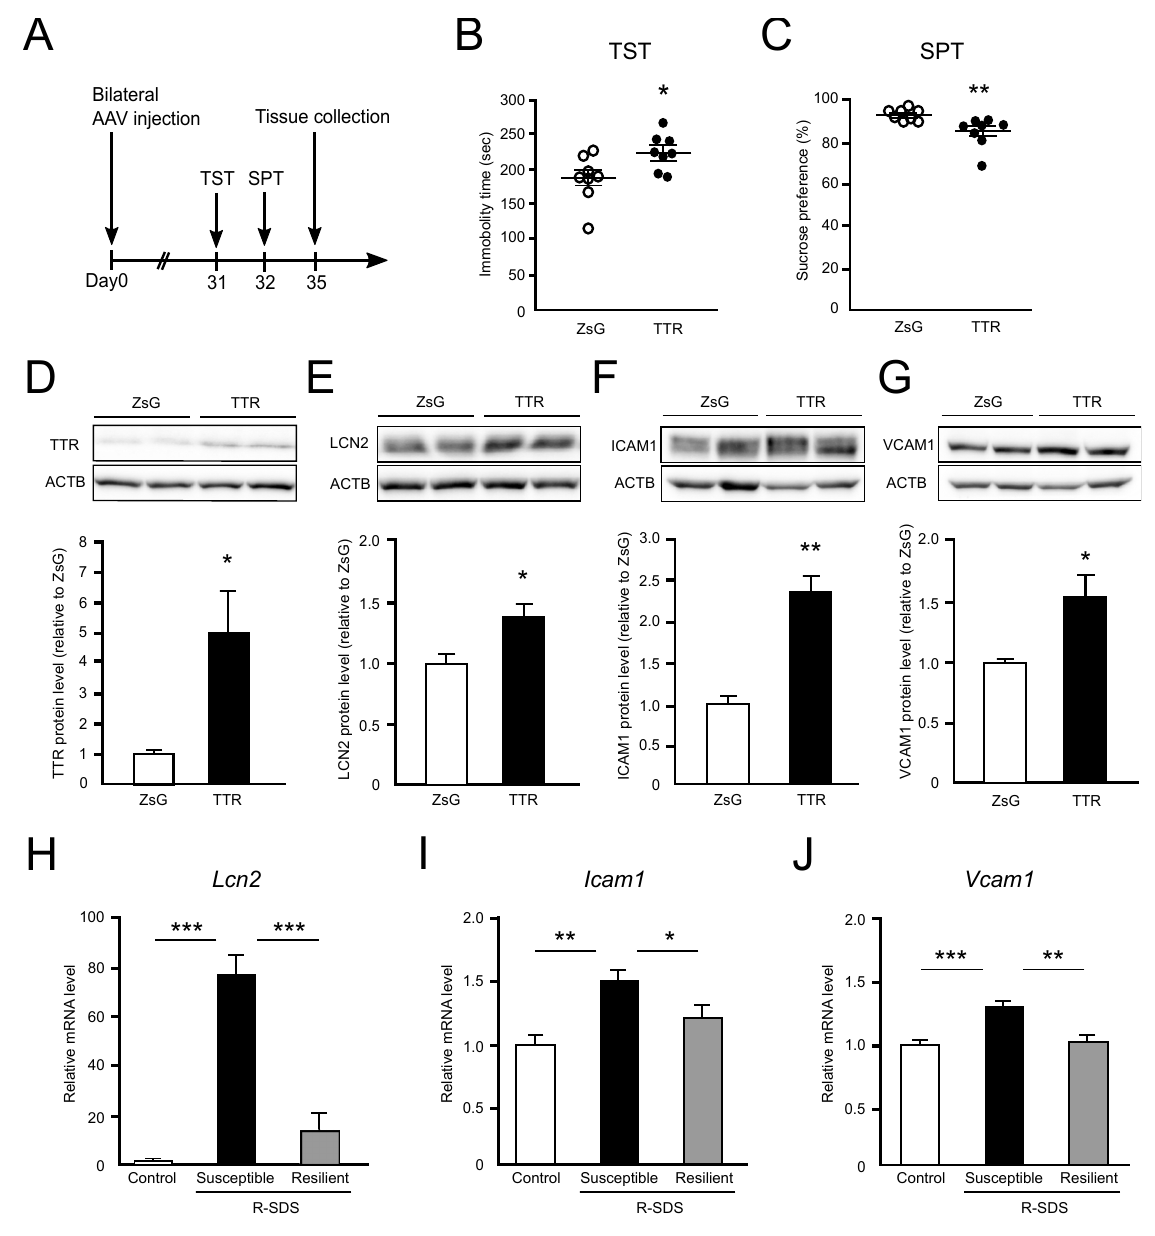
Figure 3. Effects of Ttr overexpression in the hippocampus. ( A ) Schedule of gene transfer and mouse analyses. Male B6 mice were injected bilaterally with AAV-ZsGreen1 (ZsG mice) or AAV-Ttr (TTR mice) into their hippocampus. TST, SPT, and tissue collection were performed 31, 32, and 35 days after AAV injection, respectively. ( B , C ) The immobile time in TST ( B ) and sucrose preference ( C ) of ZsG and TTR mice. Values of each individual were plotted, and mean ± SEM per group was also expressed. ZsG; n = 8, TTR; n = 8. ( D – G ) The protein levels of TTR ( D ), LCN2 ( E ), ICAM1 ( F ), and VCAM1 ( G ) in the hippocampus of the ZsG and TTR mice. Western blotting was performed using whole hippocampus extracts of the ZsG and TTR mice. Data were expressed as mean ± SEM (n = 4). ( H – J ) The mRNA levels of Lcn2 ( H ), Icam1 ( I ), and Vcam1 ( J ) in the hippocampus of the control, susceptible R-SDS, and resilient R-SDS mice. The mRNA levels were analyzed by RT-qPCR with RNA extracted from the hippocampus of the control, susceptible R-SDS, and resilient R-SDS mice. Data were expressed as mean ± SEM (n = 4–5). * p < 0.05, ** p < 0.01, *** p <